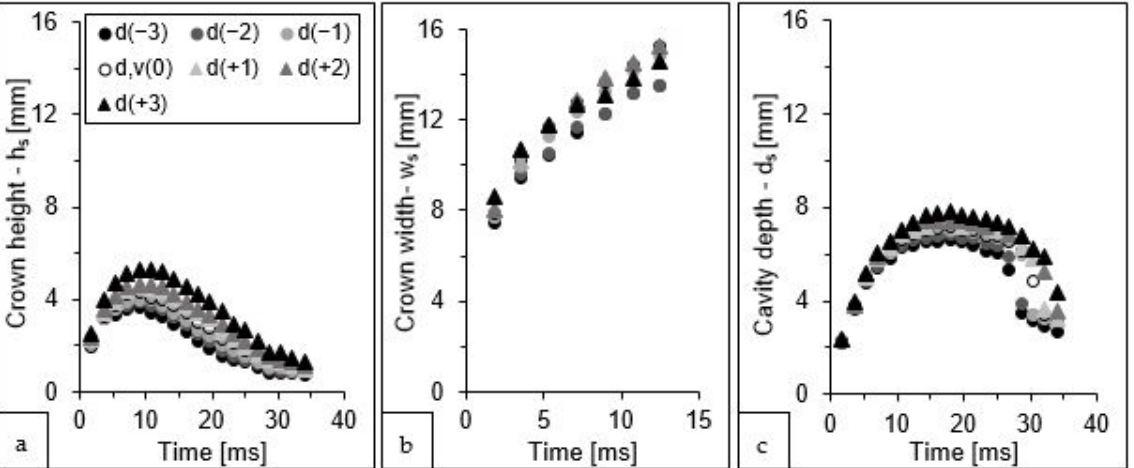
Figure 6. Change in the three splash parameters values: ( a ) height of the crown —h s ; ( b ) external width of the crown—w s ; ( c ) depth of the cavity—d s , presented in subsequent moments of the splash phenomenon for seven simulations differentiated by the diameter of the falling drop.